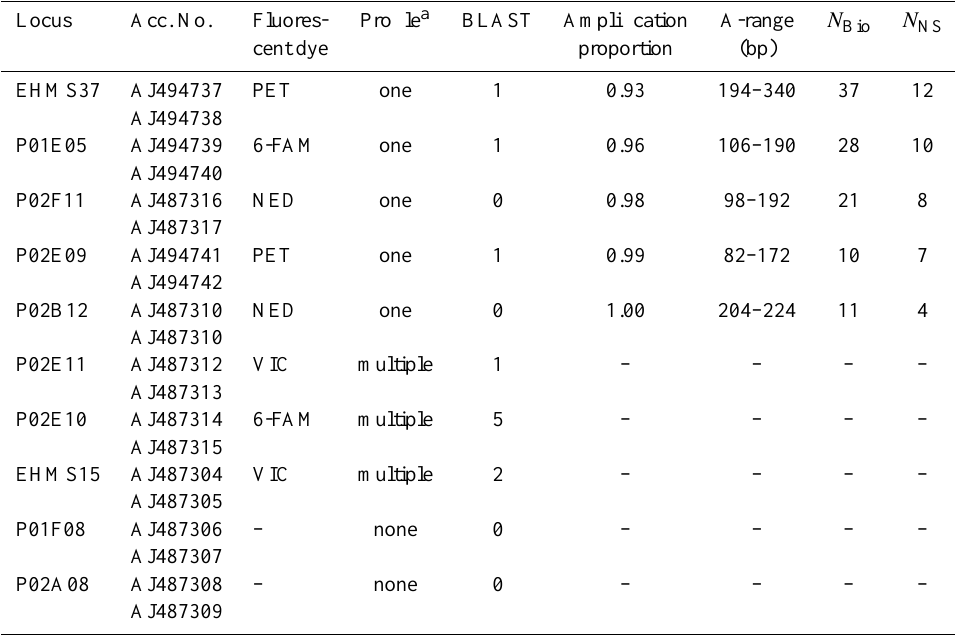
Table 1. Characteristics of the 10 microsatellite markers isolated in Emiliania huxleyi by Iglesias-Rodríguez et al. (2002, 2006). N Bio , total number of distinct alleles observed over the biogeographic data set and N NS , total number of distinct alleles observed over the North Sea Bloom data